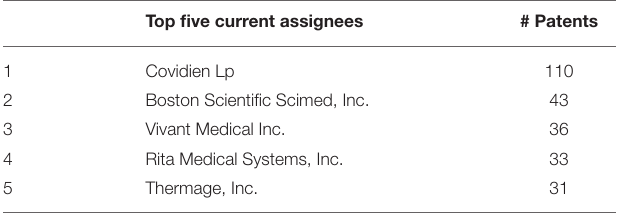
TABLE 5 | Top current assignees in the microwave/radiofrequency energy-based therapeutic domain.